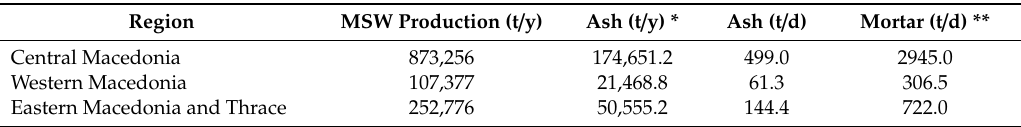
Table 5. Quantities of ash and mortar that can be produced in ZWMP plants from MSW per region of Northern Greece.